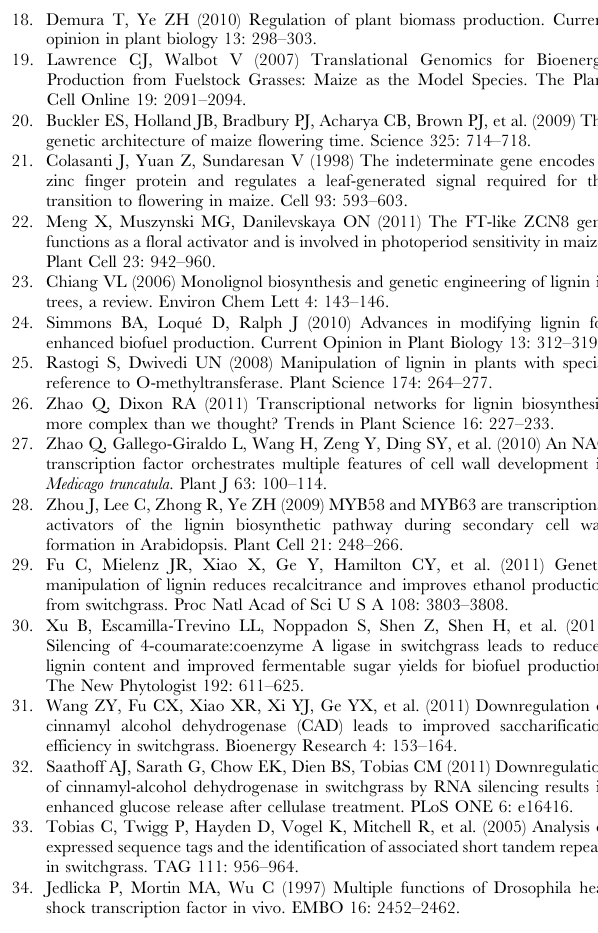
numbers indicate the nucleotide position. Figure S2 Phloroglucinol staining of the lignin deposi- tion patterns in AtLOV1 transgenic and wild type (WT) plants. The darker red stain in AtLOV1 suggests it has a higher lignin content than the WT control plant. Figure S3 The subcellular localization of AtLOV1.1 and AtLOV1.2 fused with C-terminal GFP proteins indicates that both localized to the plant nucleus. ( A ) GFP control, ( B ) AtLOV1.1:GFP, ( C ) AtLOV1.2:GFP. The GFP signal was observed under a fluorescence microscope (400 x). The green foci in ( B ) and ( C ) represent the plant nuclei. The bars represent 50 m m.